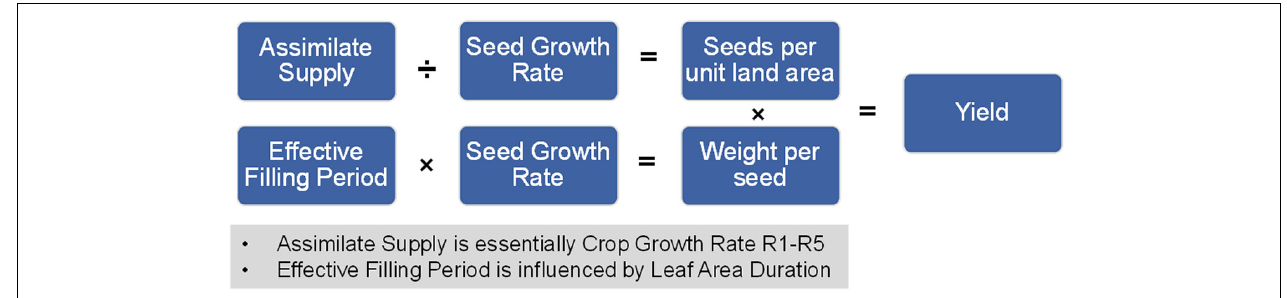
FIGURE 6 | Relationship between soybean yield-related components and yield. The mathematical relationship between soybean yield-related components and final yield on a per unit area measurement.